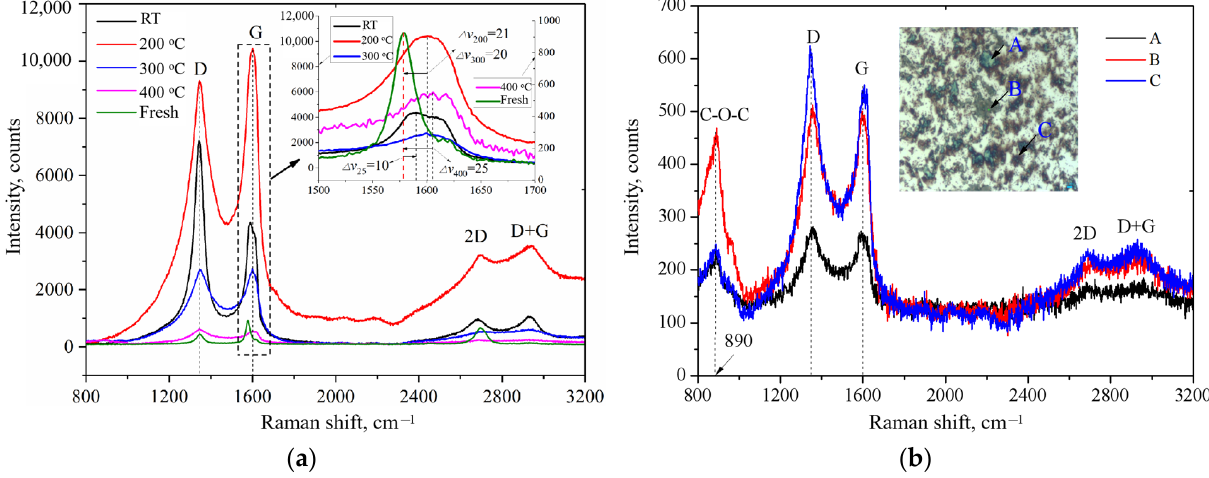
Figure 7. Raman spectra of the worn surface of WC-Ni alloy: ( a ) RT, 200 °C, 300 °C, 400 °C; ( b ) 400 °C.